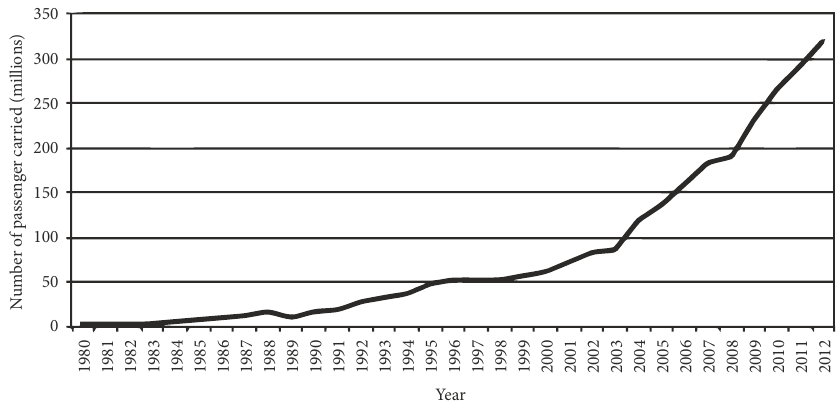
198019811982198319841985198619871988198919901991199219931994199519961997199819992000 2001 200220032004200520062007200820092010 2011 Figure 1. Passengers carried for China’s aviation industry, 1980–2012 (source: The World Bank, 2016)